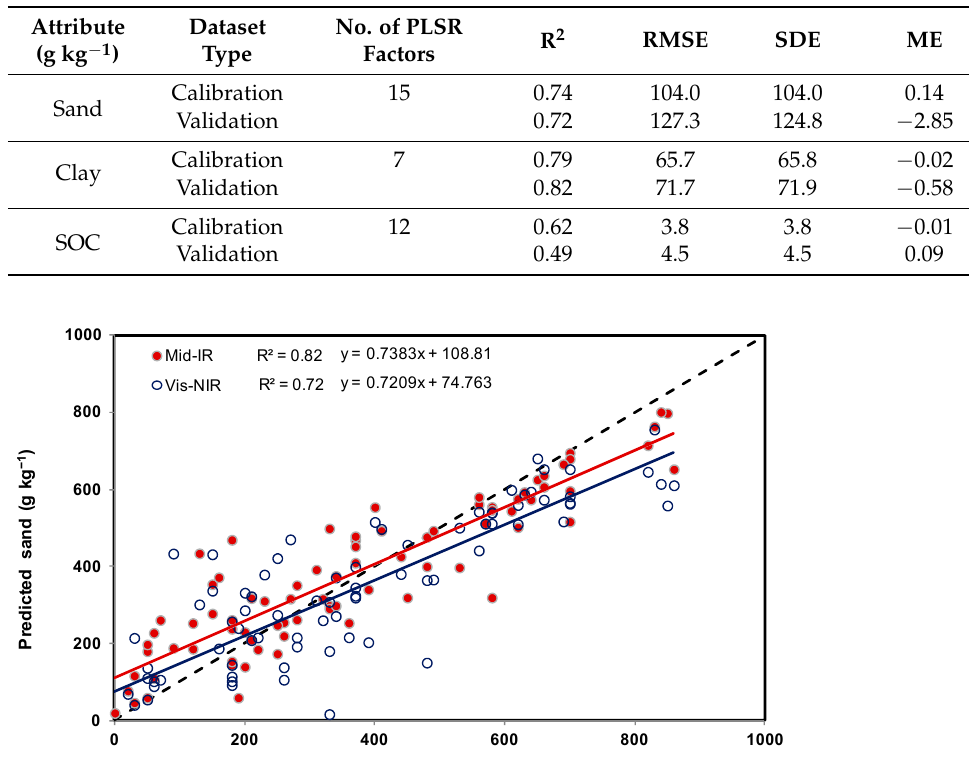
Table 4. Statistical results of PLSR with leave-one-out cross-validation trained on vis-NIR calibration dataset examples and tested on vis-NIR validation dataset examples.